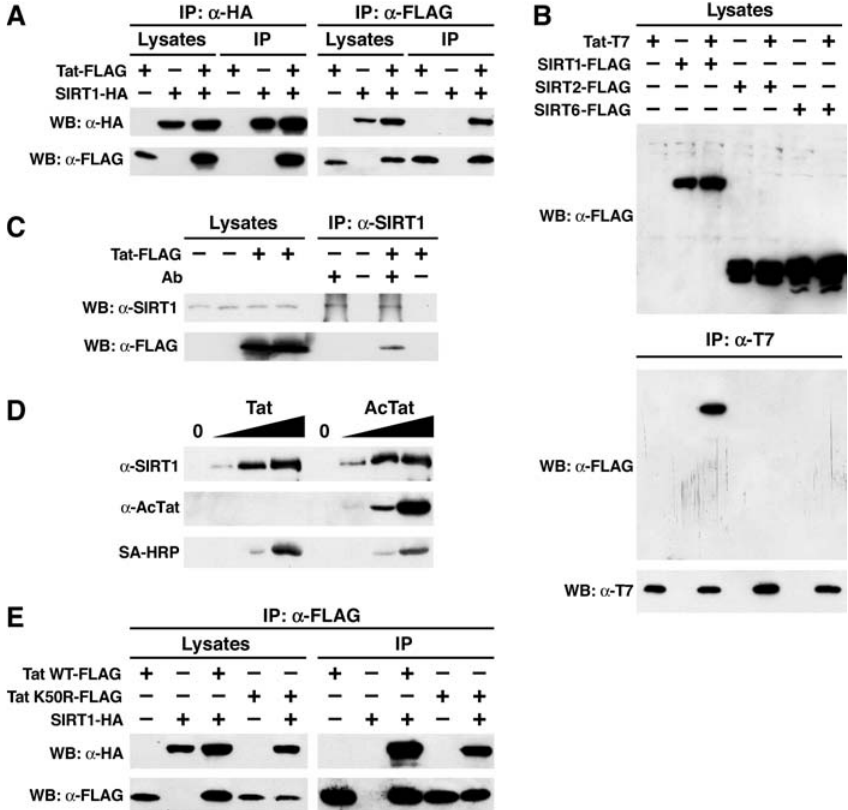
Figure 2. Physical Interaction between Tat and SIRT1 (A) Immunoprecipitation (IP) and WB of FLAG-tagged Tat (Tat-FLAG) and HA-tagged SIRT1 (SIRT1-HA) after transfection of corresponding expression vectors ( þ ) or empty vector controls ( (cid:1) ) into HEK 293 cells. (B) The same experiments as in (A) performed with T7-tagged Tat and FLAG-tagged SIRT1, SIRT2, and SIRT6. (C) Coimmunoprecipitation of FLAG-tagged Tat with endogenous SIRT1 in HEK 293 cells transfected with the Tat expression vector or the empty vector control. IPs were performed with or without rabbit a -SIRT1 antibodies. (D) WB of recombinant SIRT1 protein after pulldown with synthetic biotinylated Tat or AcTat. Tat proteins were detected with antibodies specific for acetylated lysine 50 in the Tat ARM ( a -AcTat) or SA-HRP. (E) Immunoprecipitation/WB of FLAG-tagged Tat or TatK50R and HA-tagged SIRT1. WT, wild type. DOI: